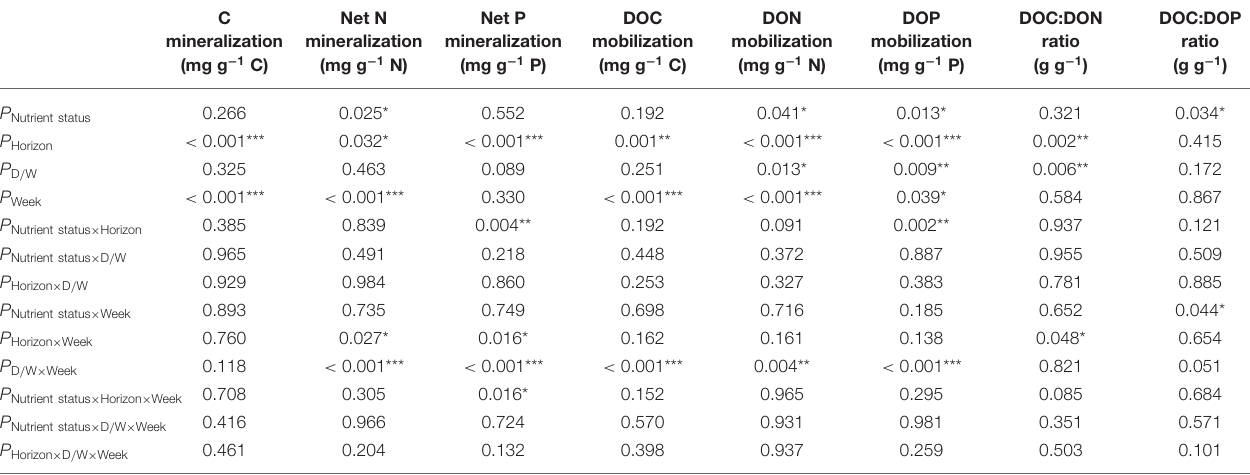
TABLE 3 | Statistical significances of the effects of site (Nutrient status of the sites), horizon (Oi, Oe-Oa, and A) and drying-rewetting (D/W) and their interactions on the temporal pattern of C mineralization, DOC, DIN, DON, DIP, DOP mobilization, as well as DOC:DON and DOC:DOP ratios in leachates. C